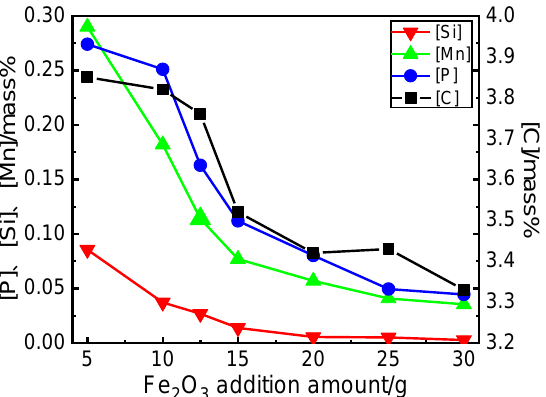
Figure 3. Effect of the Fe 2 O 3 addition amount on the contents of elements in the hot metal after dephosphorization.